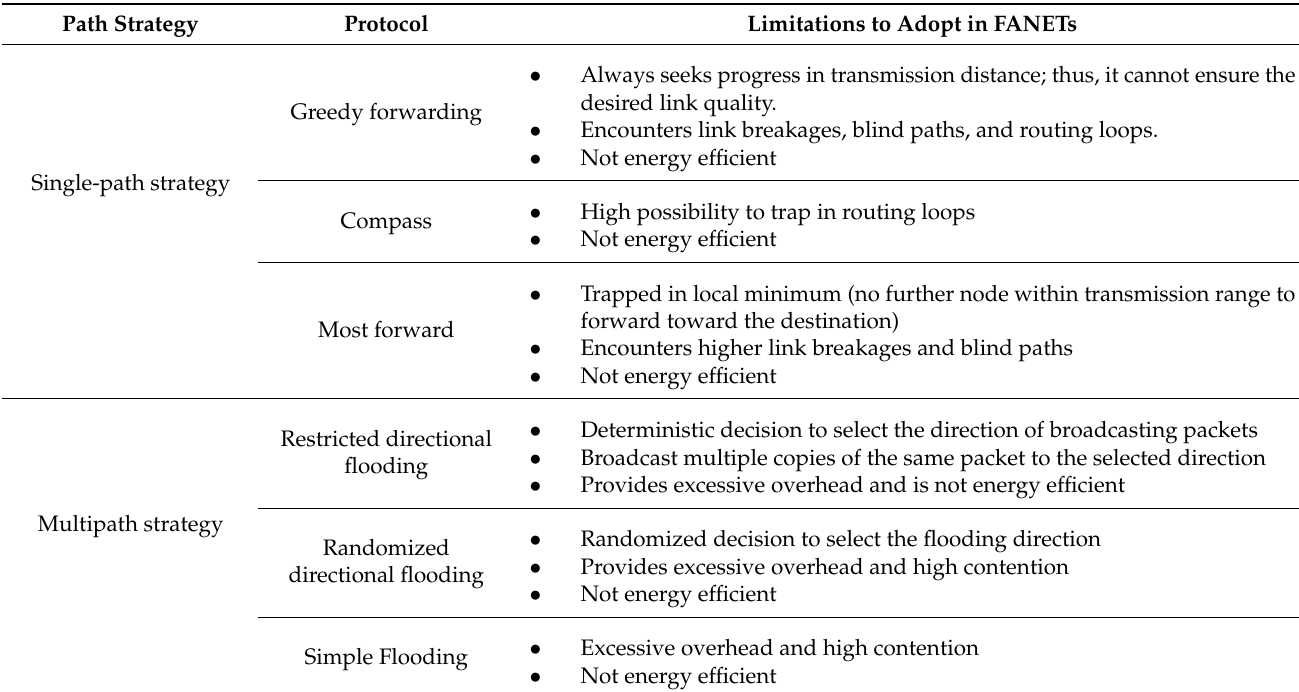
Table 3. Summary of position-based routing protocols and their limitations in FANETs